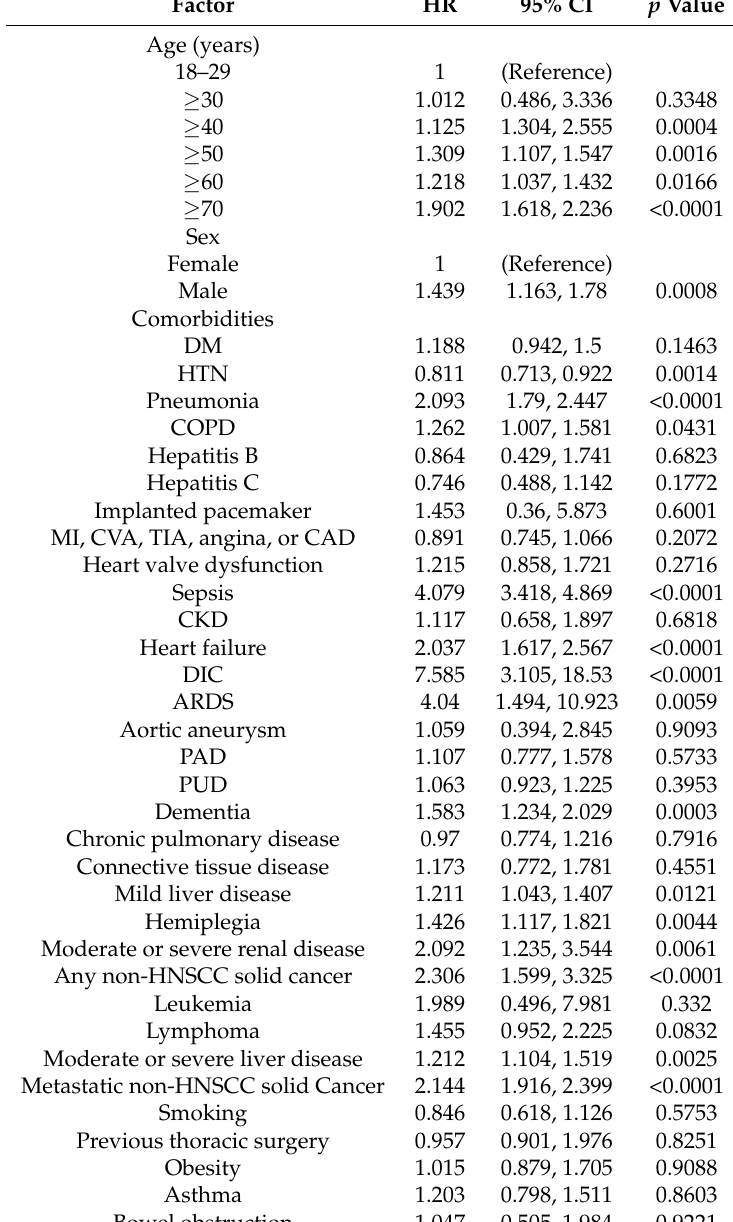
Table 3. Mortality risk assessment through multivariate Cox proportional hazard model in locoregionally advanced head and neck squamous cell carcinoma patients receiving curative